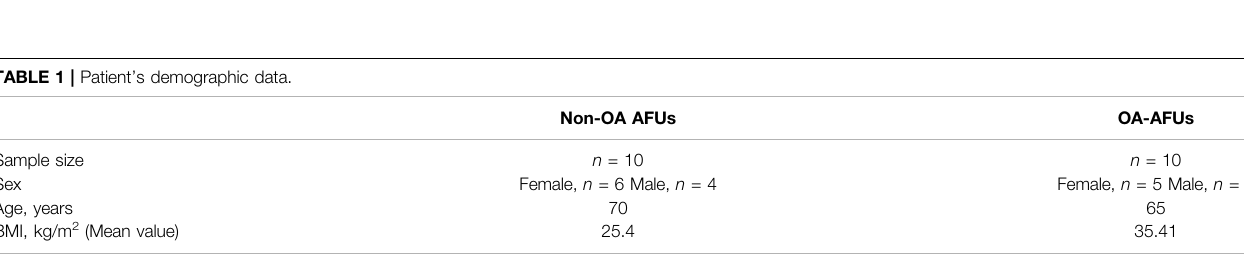
TABLE 1 | Patient ’ s demographic